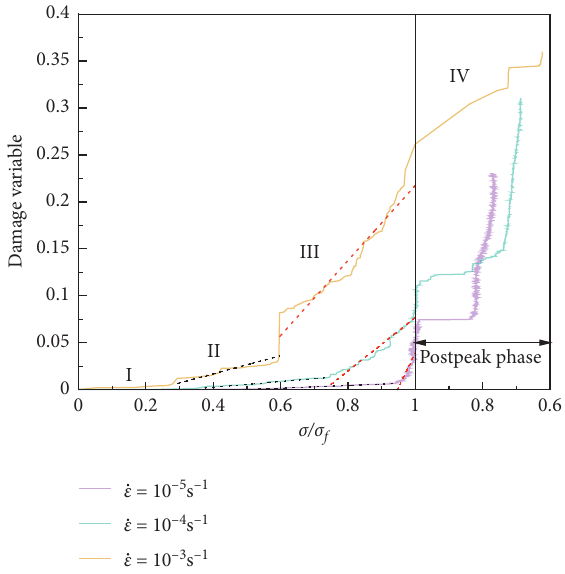
Figure 5: Damage evolution under different strain